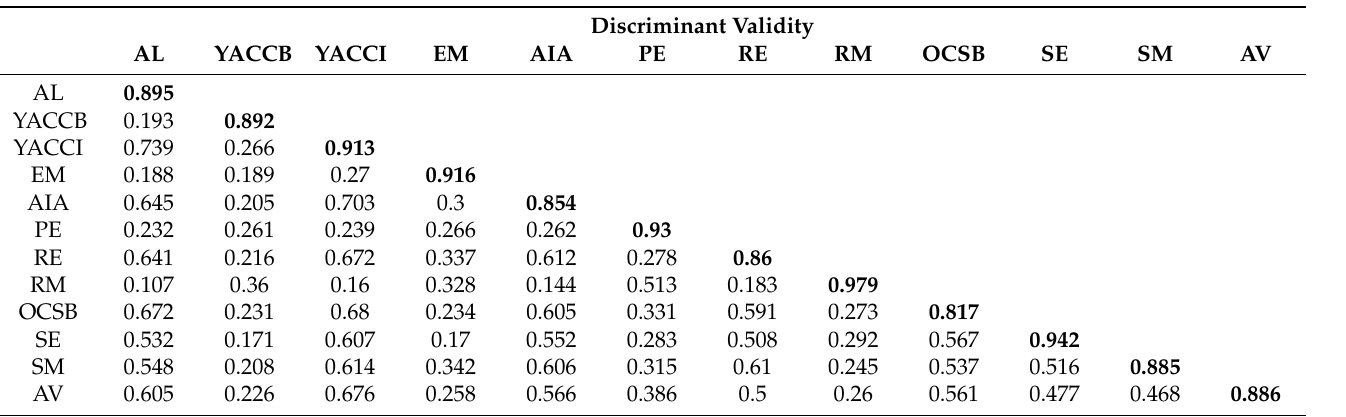
Table 4. Correlation results of the